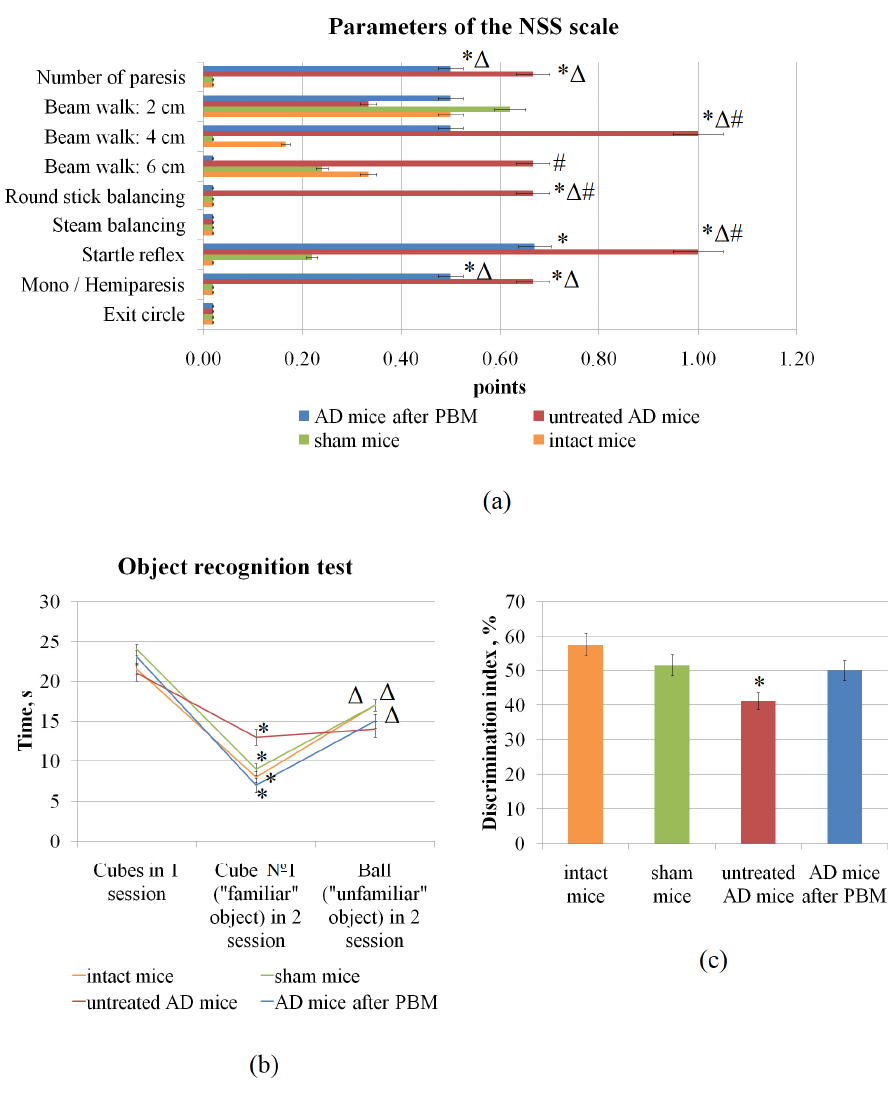
Figure 2. The PS effects on the memory and neurological status of mice with Alzheimer’s disease (AD): ( a ) The assessment of the neurobehavioral status of mice on the NSS scale (*— p < 0.05 vs. intact mice; Δ— p < 0.05 vs. sham mice; #—between untreated AD mice and AD mice received PS); ( b ) The object recognition test, reflecting the processes of learning, recognition and memorization (*— p < 0.05 vs. cubes in 1 session; Δ— p < 0.05 vs. cube Nº1 («familiar» object) in 2 session); ( c ) The discrimination index by the object recognition test (*— p < 0.05 vs. sham mice). n = 10 for each group.